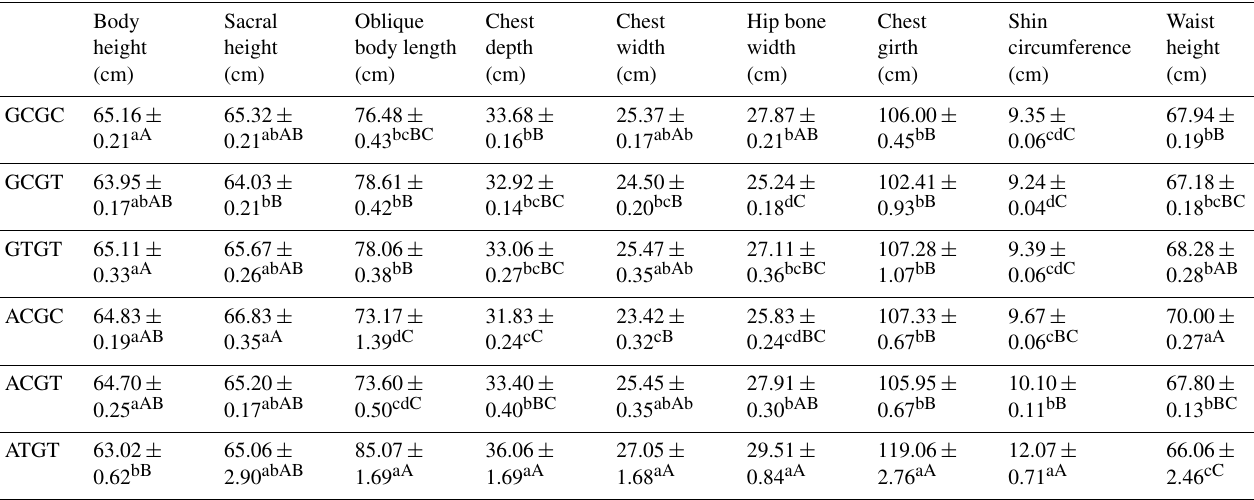
Table A9. Association analysis of haplotype body